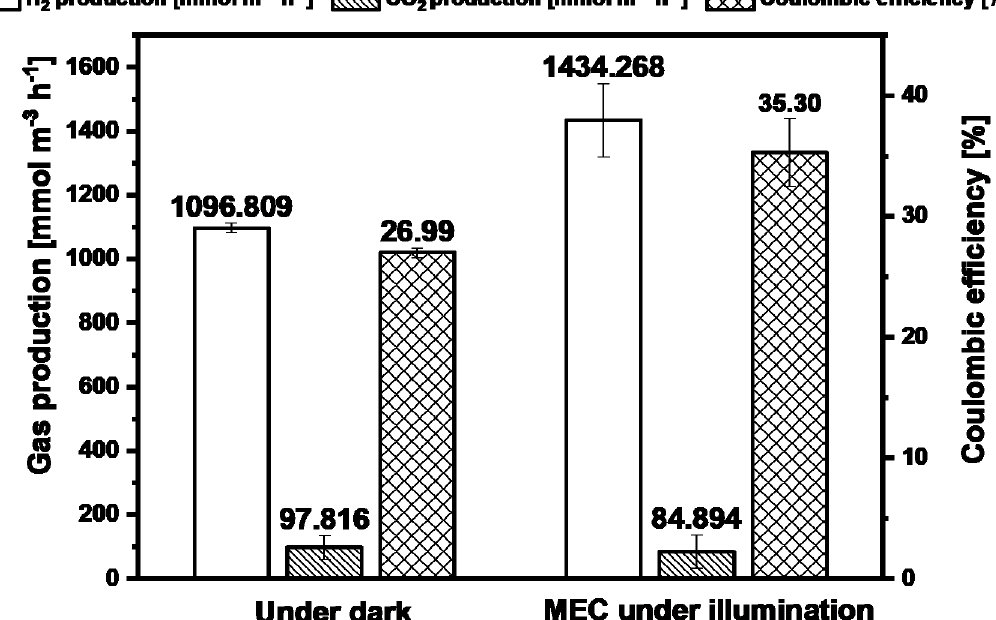
Figure 5. H 2 production rate, CO 2 production rate, and coulombic efficiency by the MEC under dark condition and hybrid MEC under simulated solar light for 24 h.